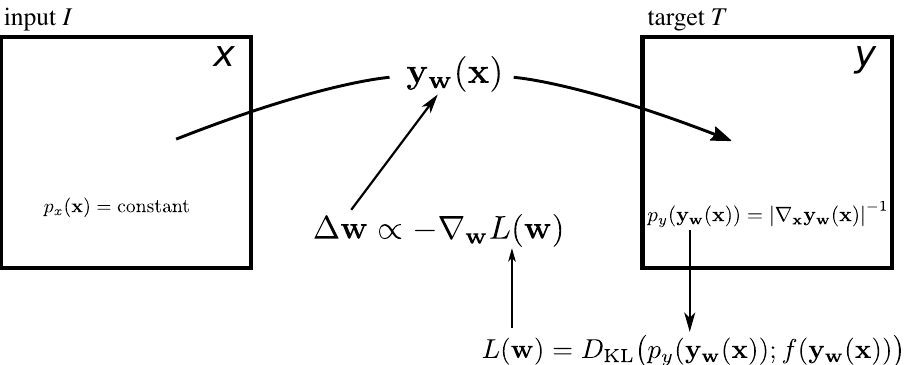
( x ) between a uniformly sampled input space and a Figure 1: The ANN is a map y w target space on which it induces a non-trivial pdf. During training, the parameters w of the ANN are adjusted to minimize loss function L ( w ) , the KL divergence between the induced and target pdfs. From Ref. [ 1 ] .